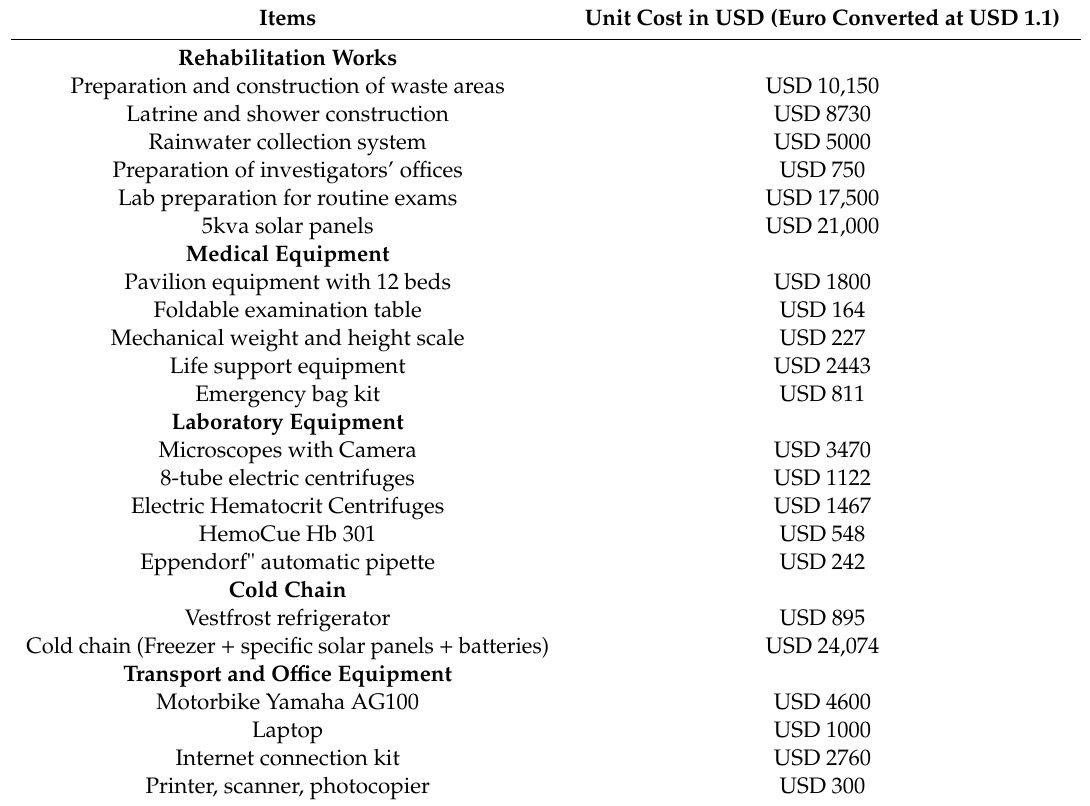
Table 3. Cost of the main material resources provided to a model